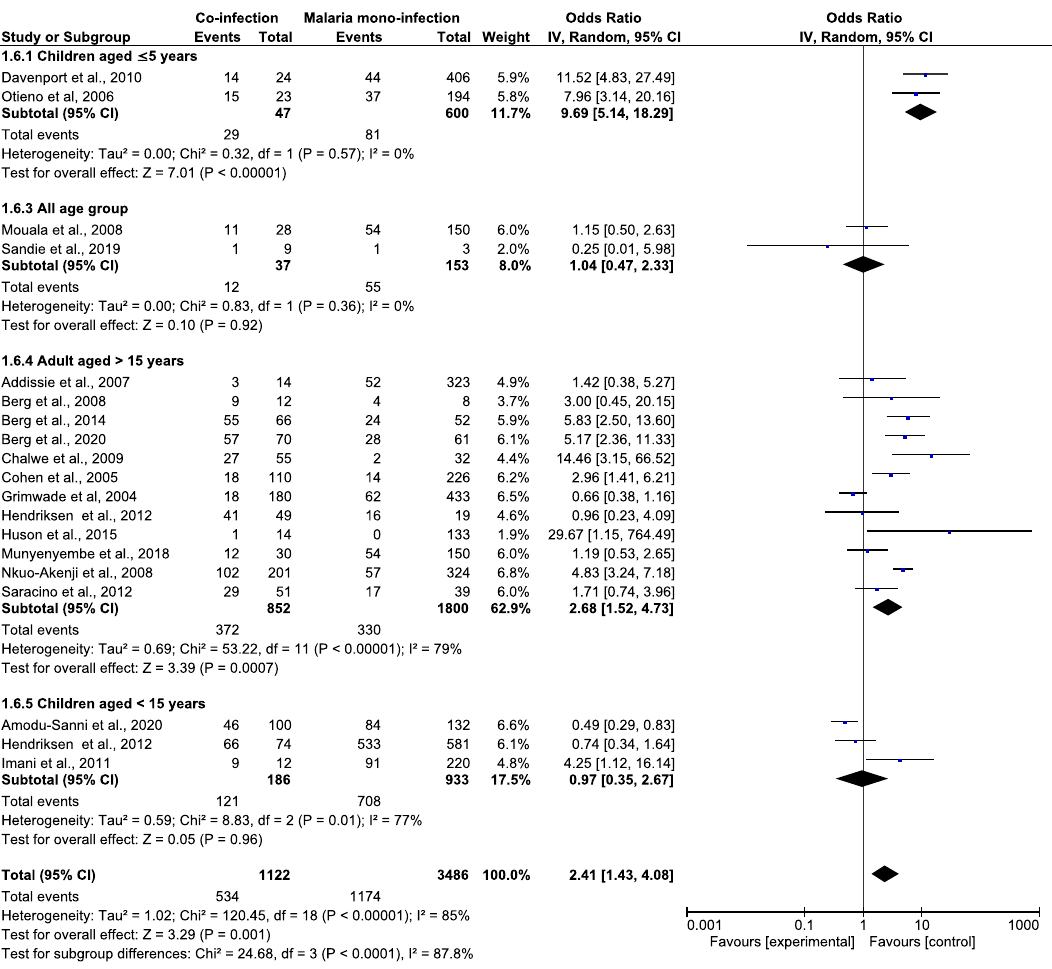
Figure 3. The risk of severe malaria in Plasmodium spp. and HIV co-infected patients.